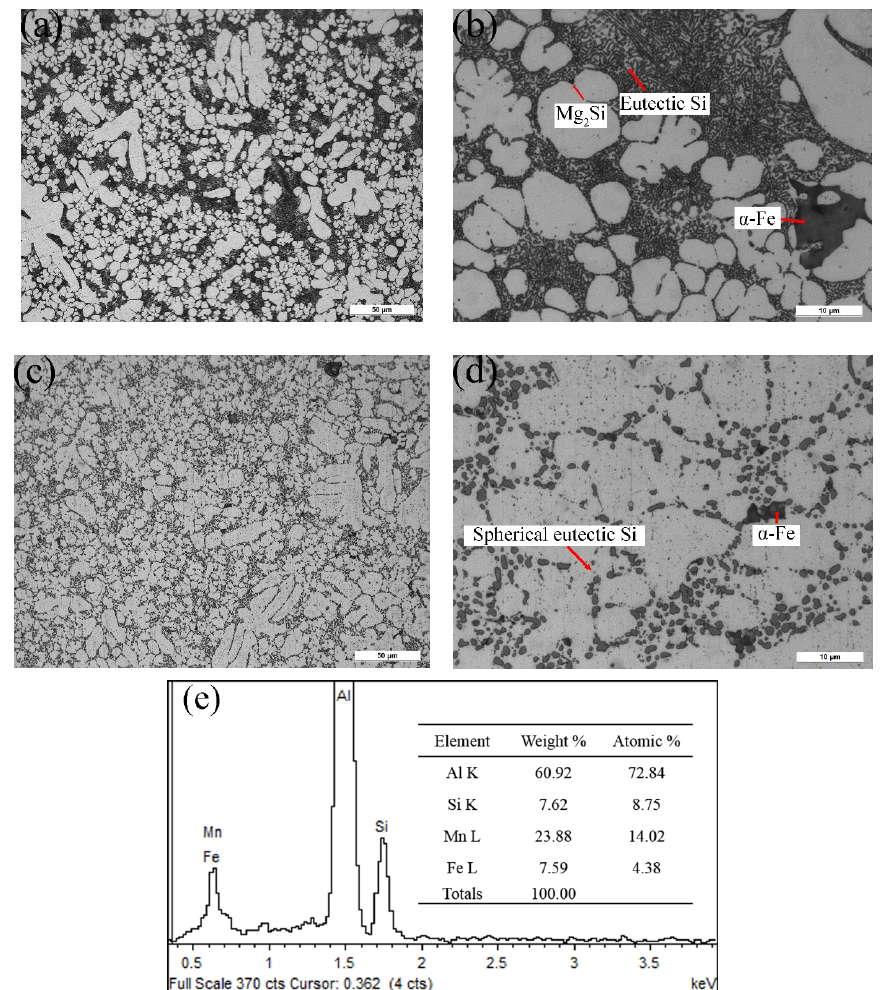
Figure 2. The microstructure of AlSiMgMn alloy. ( a , b ) As-cast; ( c , d ) T6 heat treatment; ( e ) energy dispersive spectroscopy (EDS) analysis results of α -Fe intermetallics.